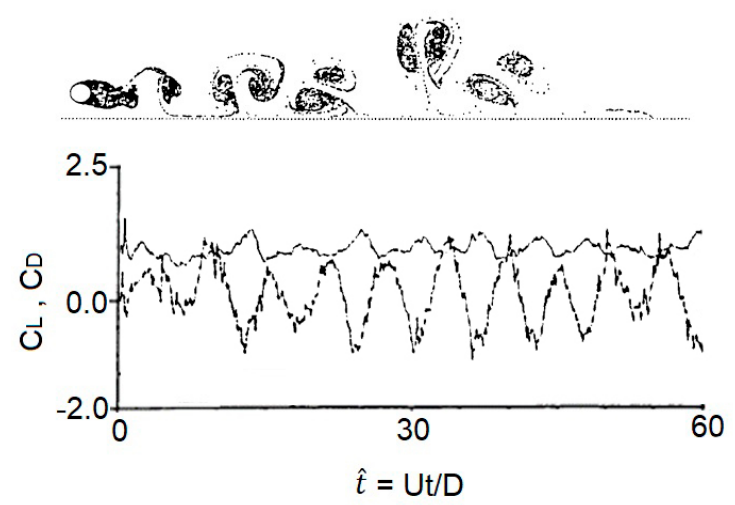
Figure 8. The flow pattern and force coefficients for G/D = 1 and Re = 100,000.